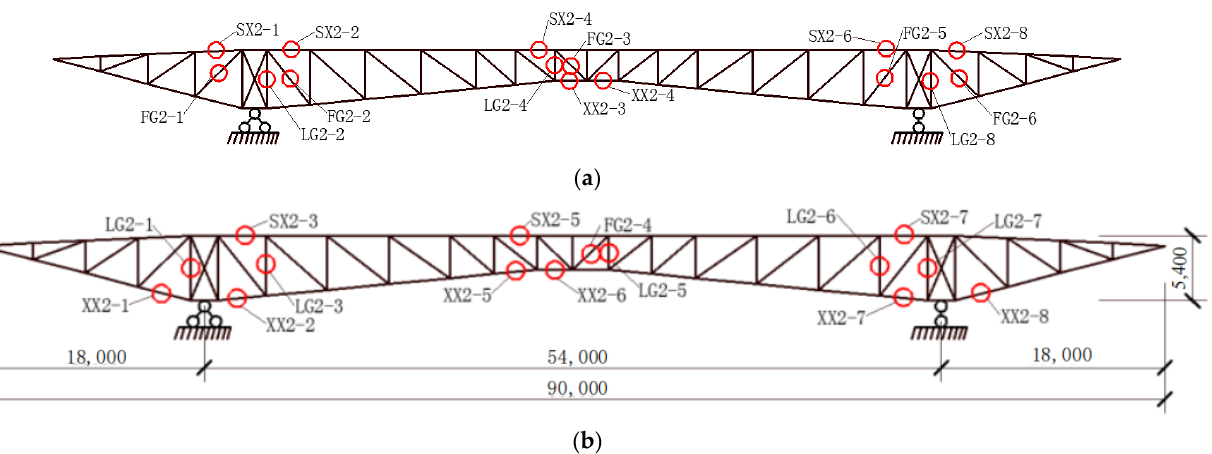
Figure 10. Arrangement of the stress measurement points for ( a ) the view from the north side and ( b ) the view from the south side.